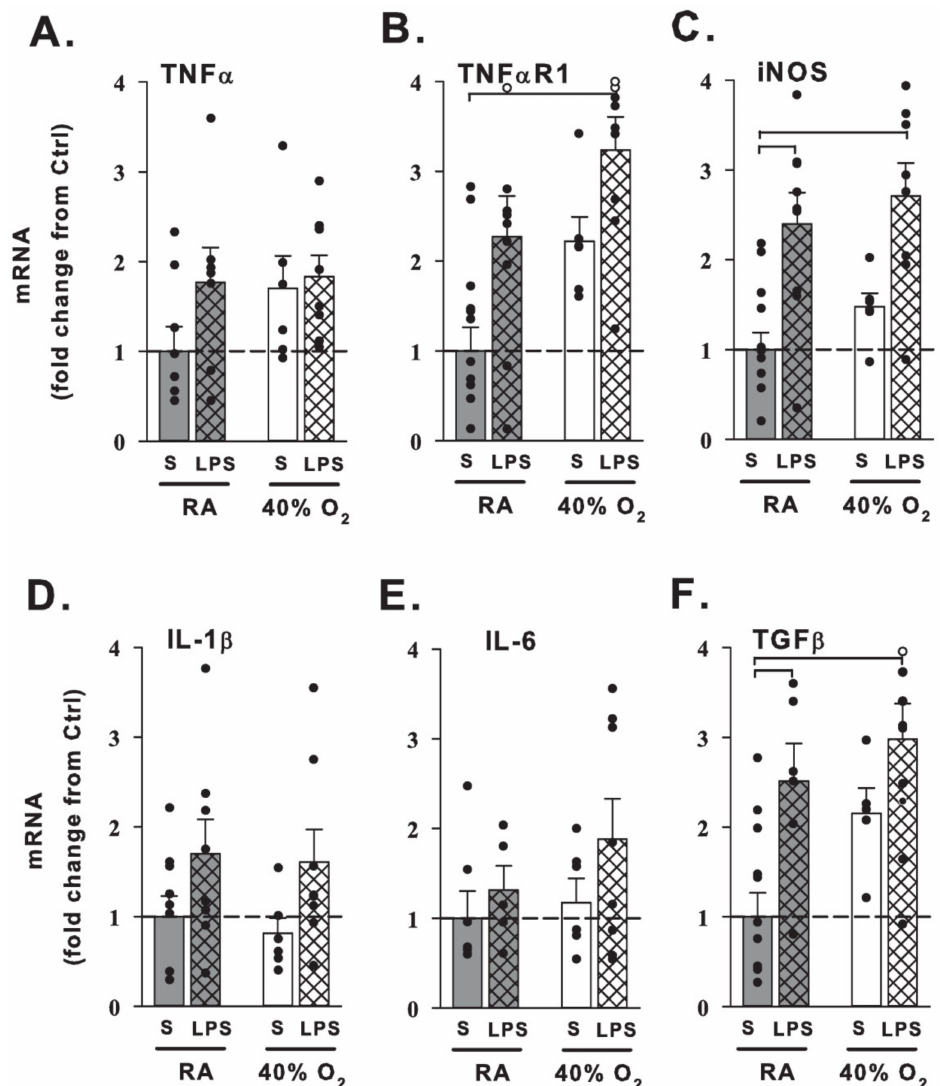
Figure 4. Changes in lung mRNA expression from 21-day-old mice. qRT-PCR of inflammatory-related molecules and receptors ( A – F ) from 21-day-old mice that received one week of neonatal (P1–7) hyperoxia (40% O 2 , white bars) or normoxia (RA, gray bars) and were born from pregnant dams that received an i.p. injection of saline (S, no cross-hatches) or LPS (cross-hatches) at E18 stage of pregnancy. Prenatal maternal LPS treatment with room air increased inducible nitric oxide synthase (iNOS; C ) and transforming growth factor (TGF β ; F ) mRNA expression in the lung. Hyperoxia mice pretreated with maternal LPS had increased tumor necrosis factor receptor (TNF α R1; B ), iNOS ( C ) and TGF β ( F ) mRNA expression compared to control mice. Data are expressed as fold change from saline + normoxia control mice (S+RA). Filled dots indicate individual animals and open dots exceed the 4-fold change of axis (TNF α R1: RA+LPS 5.0-fold change, 40% O 2 +LPS 4.2 and 4.2; TGF β : 40% O 2 +LPS 4.7, respectively). Bar graph values are the means + 1SEM; brackets indicate p < 0.05 vs.